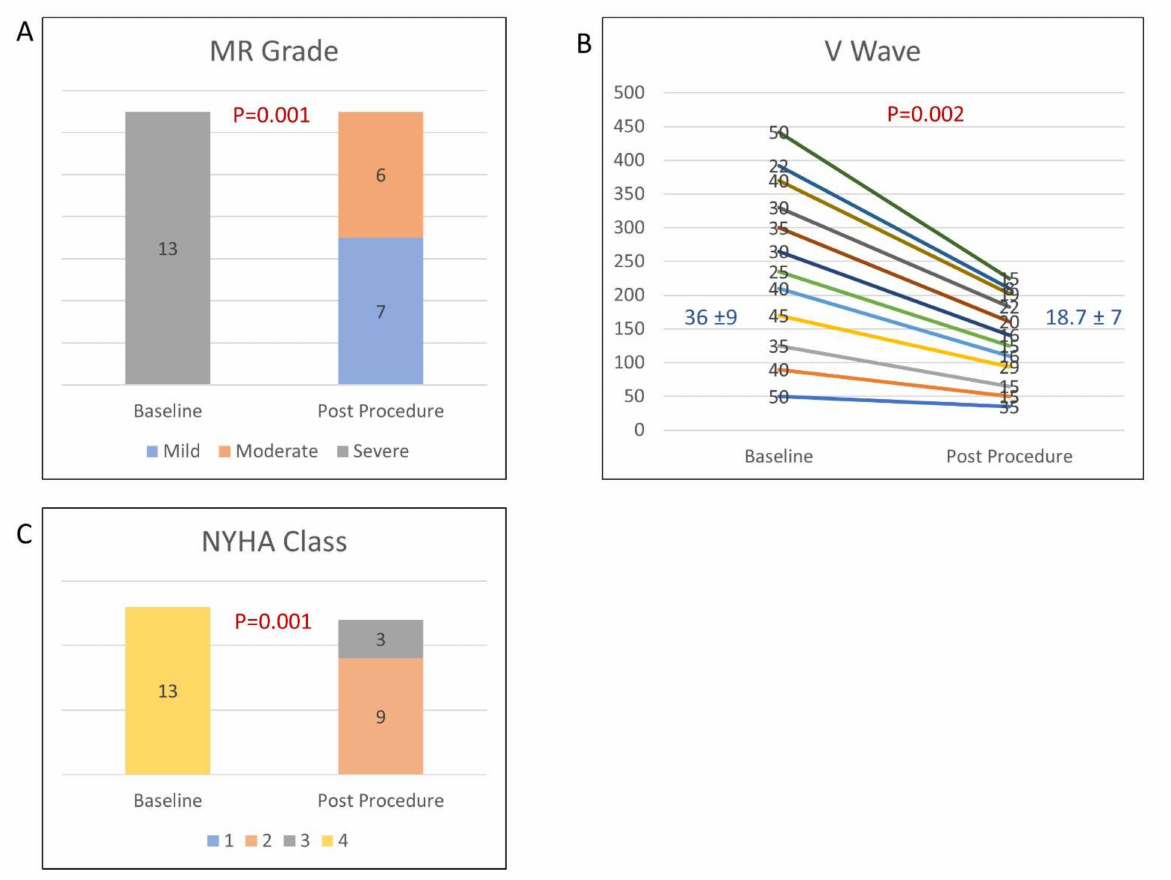
Figure 2. The impact of TEER procedure on: ( A ) severity of mitral regurgitation (MR); ( B ) left atrial V-wave; ( C ) NYHA